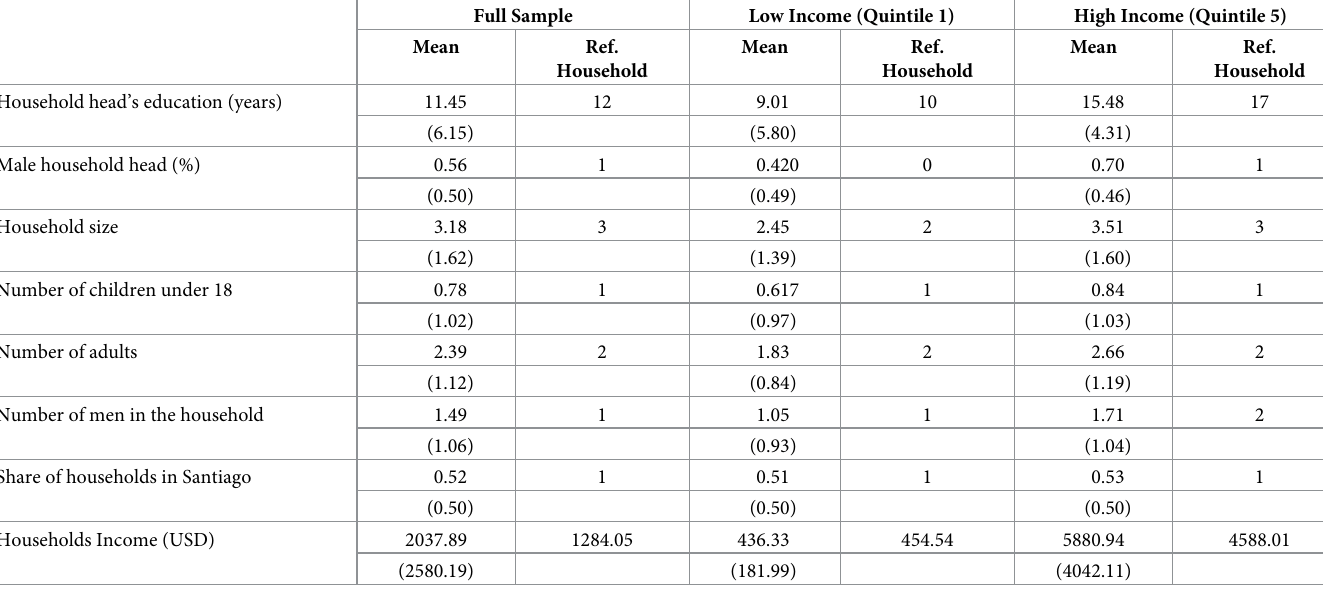
Table 1. Household descriptive